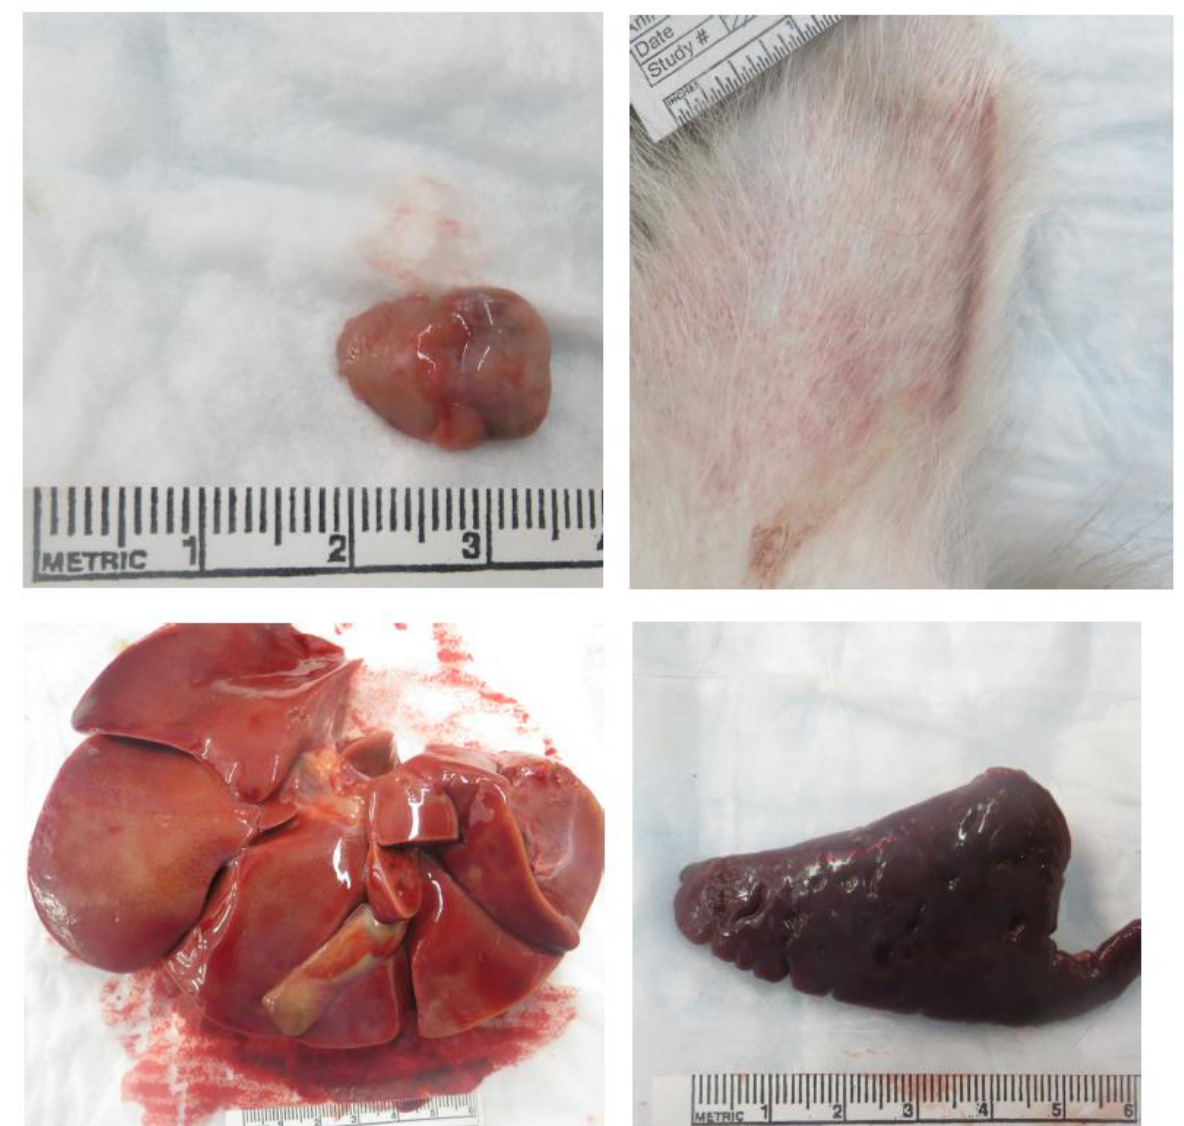
Figure 7. Representative images from gross necropsy. Macroscopic Findings at Necropsy in cynomolgus macaques intramuscularly exposed to SUDV Gulu. Animal 480 (unscheduled euthanasia, Day 11), enlarged axillary lymph node. Animal 494 (unscheduled euthanasia, Day 13), skin rash. Animal 488 (unscheduled euthanasia, Day 9), pale liver. Animal 492 (unscheduled euthanasia, Day 8), enlarged spleen.